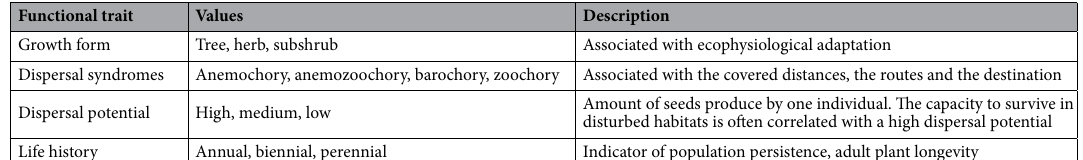
Table 2. Description of functional traits selected of plant species in eucalypt plantations. Information were collected from 58,65,72,87